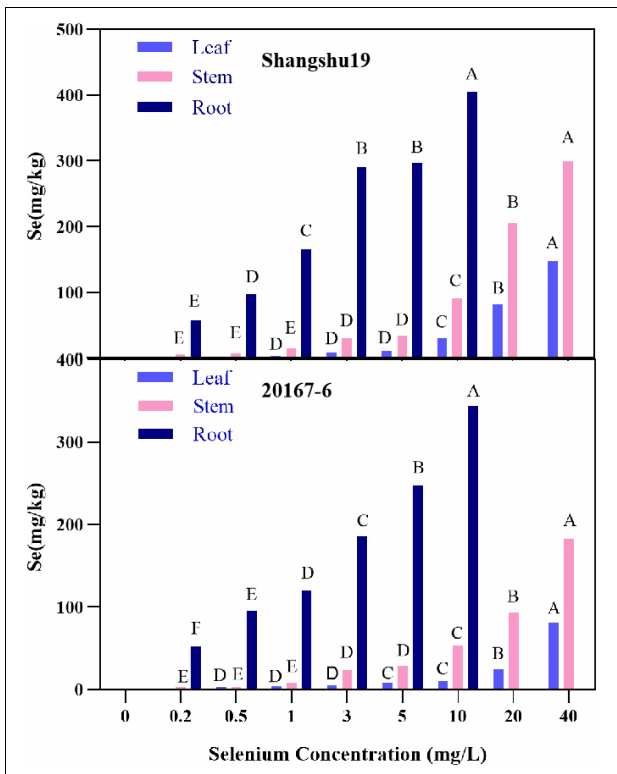
FIGURE 9 | Effects of different selenium concentrations on the distribution of selenium content in Shangshu19 and 20167-6. Different capital letters in the same category indicated that there were significant differences between Se treatments (Sig <